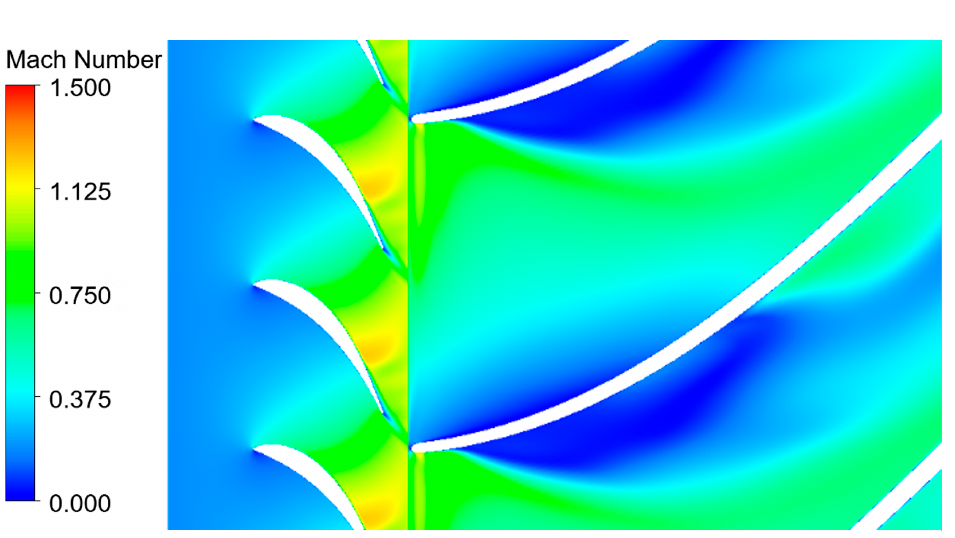
Figure 5. Contour plot of the blade-to-blade view of the Mach number at the leading edge of the rotor blade.